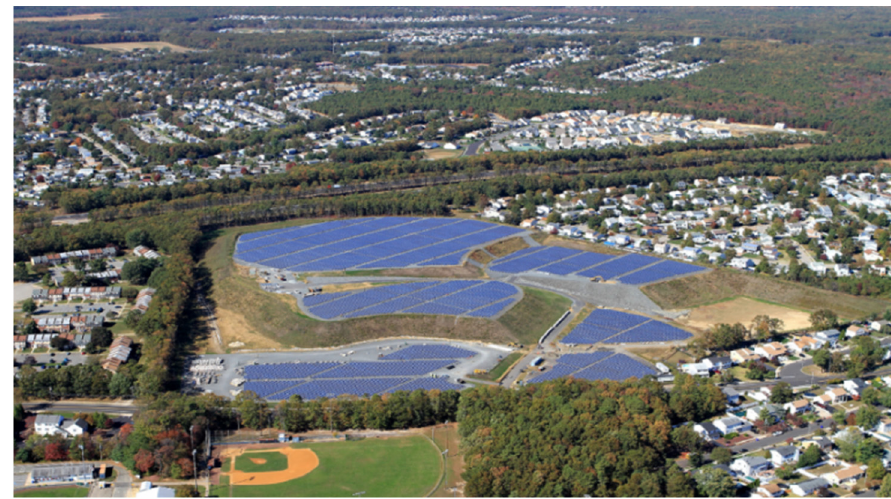
Figure 8. Brick Town landfill. Solar panel view [38].